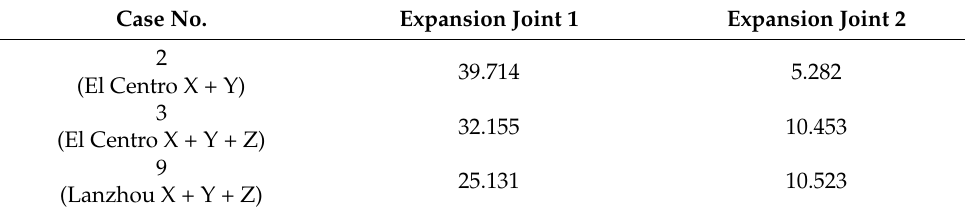
Table 6. Relative displacement (mm).